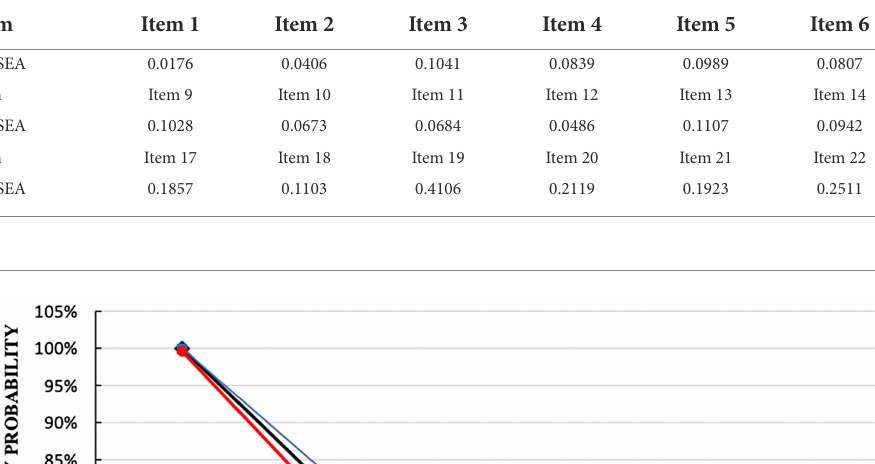
TABLE 6 RMSEA information of the test items.